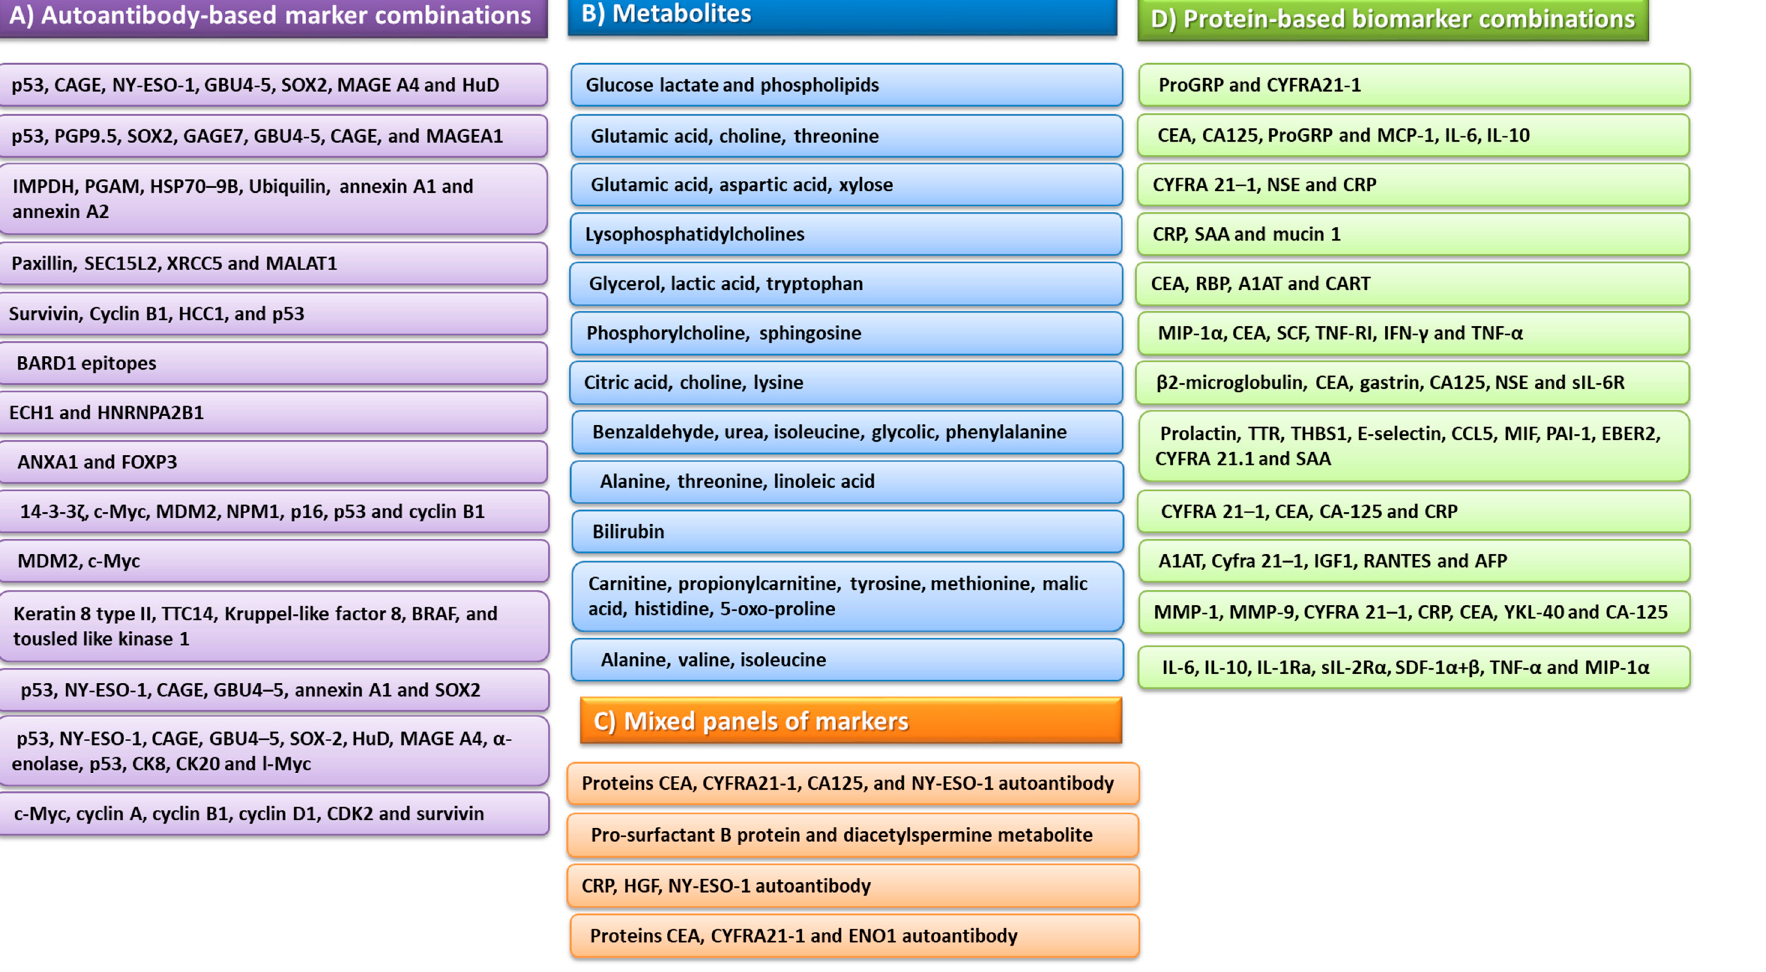
Figure 4. Biomarker molecules for use in the diagnostic process of lung cancer (based on [313–336]). Abbreviations: p53—tumor protein P53; CAGE—cancer- associated gene protein; NY-ESO-1—New York esophageal squamous cell carcinoma-1; SOX2—SRY-box transcription factor 2; MAGEA4—melanoma-associated antigen 4; HuD—ELAV-like protein 4; PGP 9.5—protein gene product 9.5; GAGE7—G antigen 7; MAGEA1—melanoma-associated antigen 1;